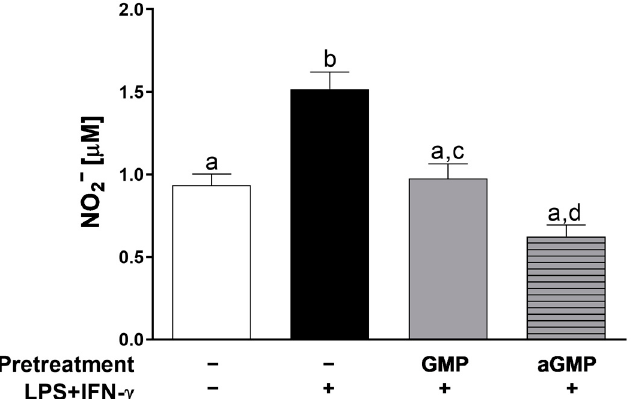
Figure 3. Effect of GMP and aGMP on NO production by stimulated U937 macrophages. Cells were incubated (pretreated) in the absence or presence of GMP (2.5 µg/µL) or aGMP (2.5 µg/µL) for 12 h and later stimulated with LPS (10 µg/mL) and IFN- γ (20 ng/mL) for 24 h ( n = 9, 3 independent experiments in triplicate). Means followed by different letters (a, b, c, d) are significantly different.